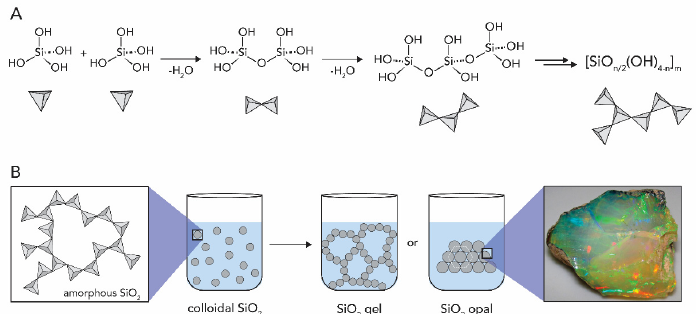
Figure 3. The silica formation. ( A ) Condensation of silicic acid Si(OH) 4 to (hydrated) SiO 2 polymers. ( B ) Silica gel and opal formation. Opal image by James St. John, published under Creative Commons Attribution (CC BY 2.0) license.